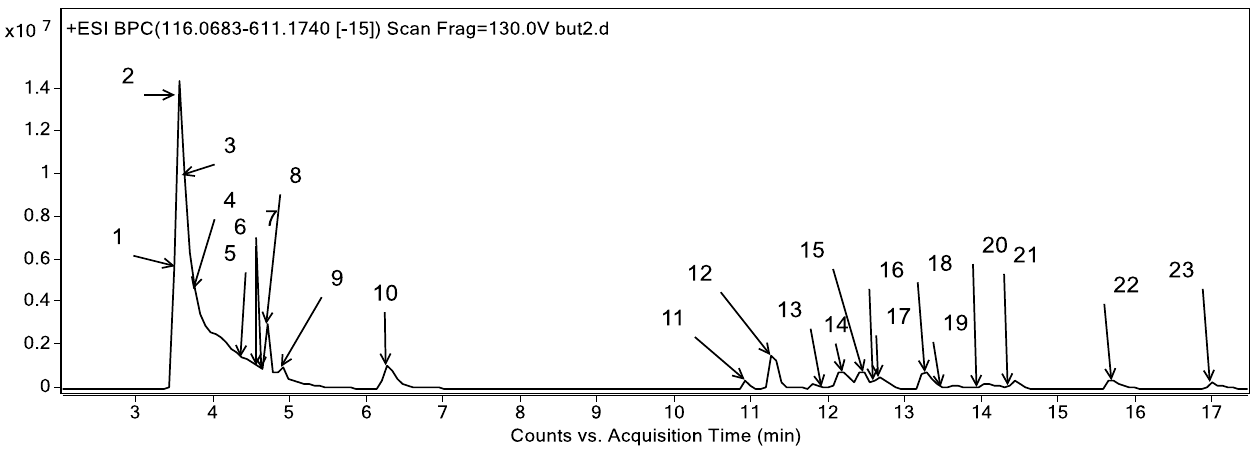
Figure 8. Base peak chromatogram of the n-butanol fraction of Colvillea racemosa total extract (CRB) in positive mode at wavelength 250 nm.